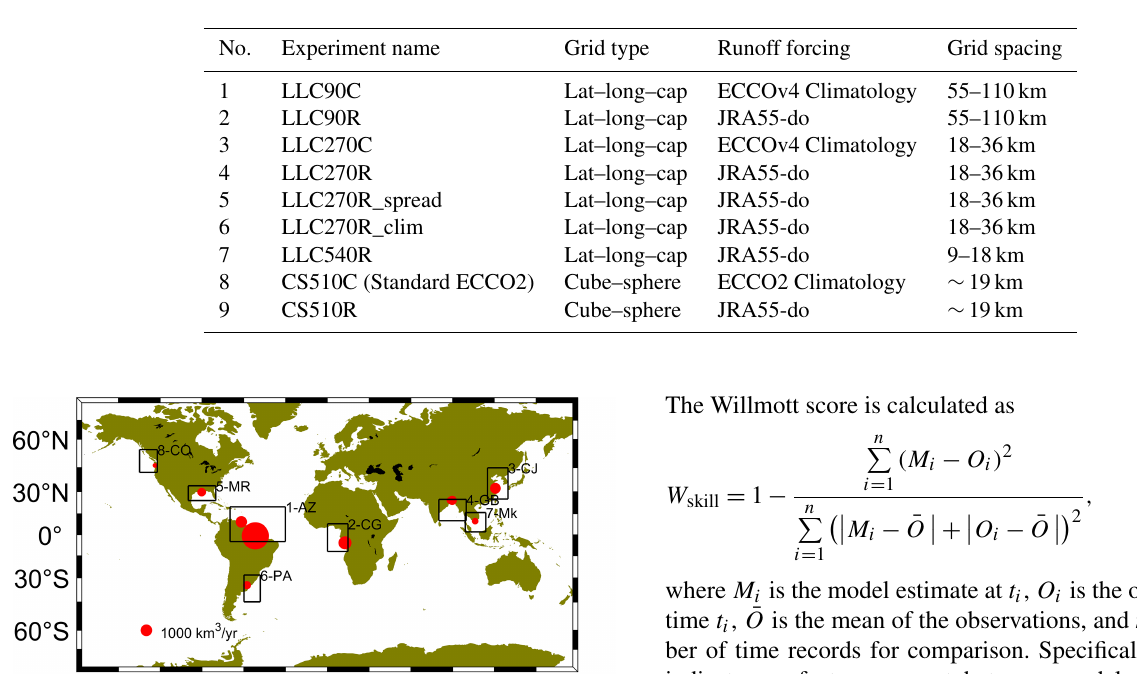
Table 1. Summary of all experiments. The ECCOv4 and ECCO2 climatological runoff is derived from Fekete et al. (2002) and Stammer et al. (2004), respectively. A comparison of runoff forcings is shown in Fig. S1.